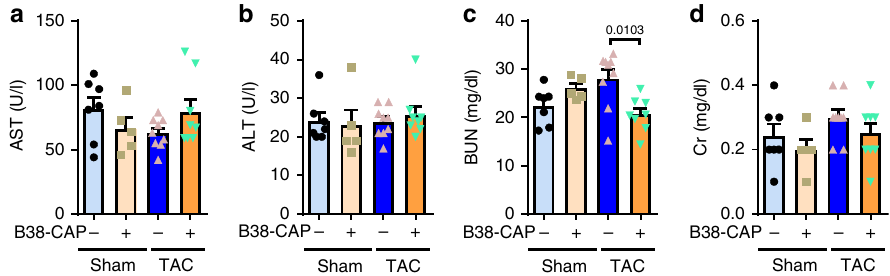
Fig. 6 No overt toxic effects of B38-CAP on liver and kidney. a , b Liver function test with measurements of aspartate aminotransferase (AST) ( a ) and alanine aminotransferase (ALT) ( b ) in the blood. c , d Kidney function assessment with measurements of BUN ( c ) and Creatinine (Cr) ( d ) in the blood. sham + vehicle ( n = 7), sham + B38-CAP ( n = 5), TAC + vehicle ( n = 9), and TAC + B38-CAP ( n = 8). All values are means ± SEM. Two-way ANOVA with Sidak ’ s multiple-comparisons test. Numbers above square brackets show signi fi cant P